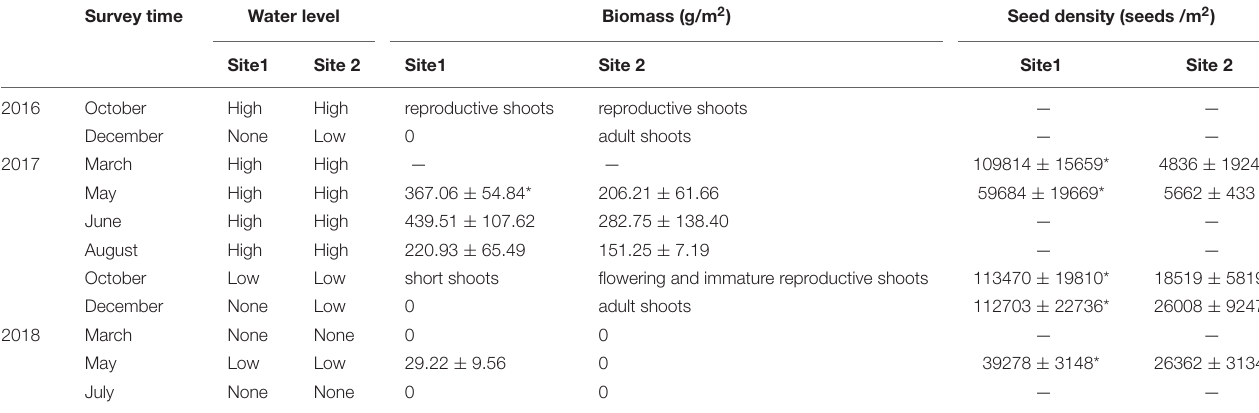
TABLE 1 | Seasonal changes in R. sinensis populations and water levels at two study sites. Survey time